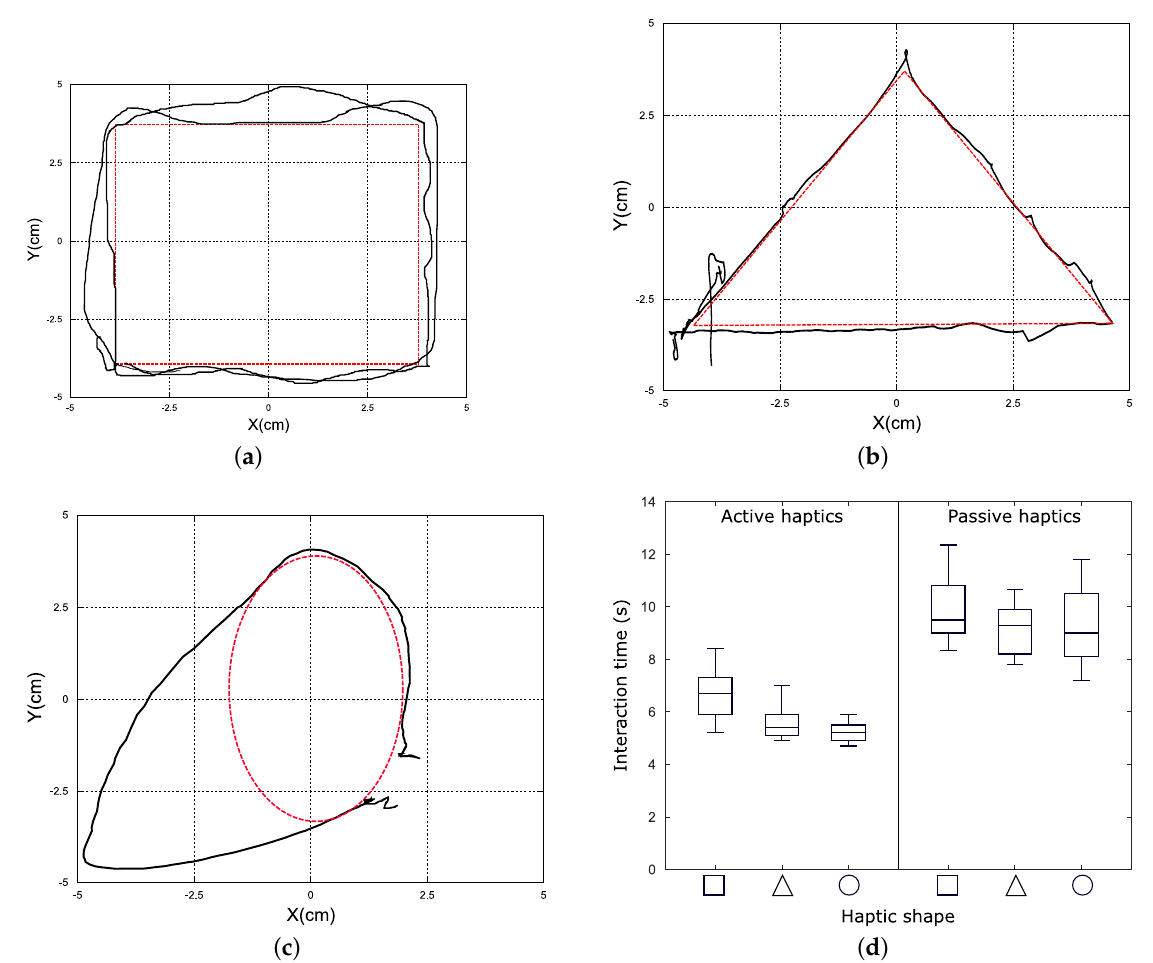
Figure 5. Shape recognition experiment: Examples of movements recorded from the subjects: ( a ) square, ( b ) triangle, and ( c ) circle. The red broken line represents the virtual shape. ( d ) Box plot analysis for the interaction time by shape for both exploration